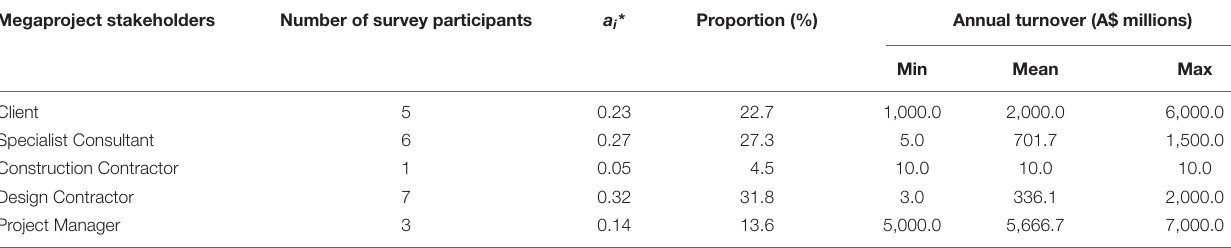
TABLE 3 | Profile of survey participants from megaprojects in Australia.